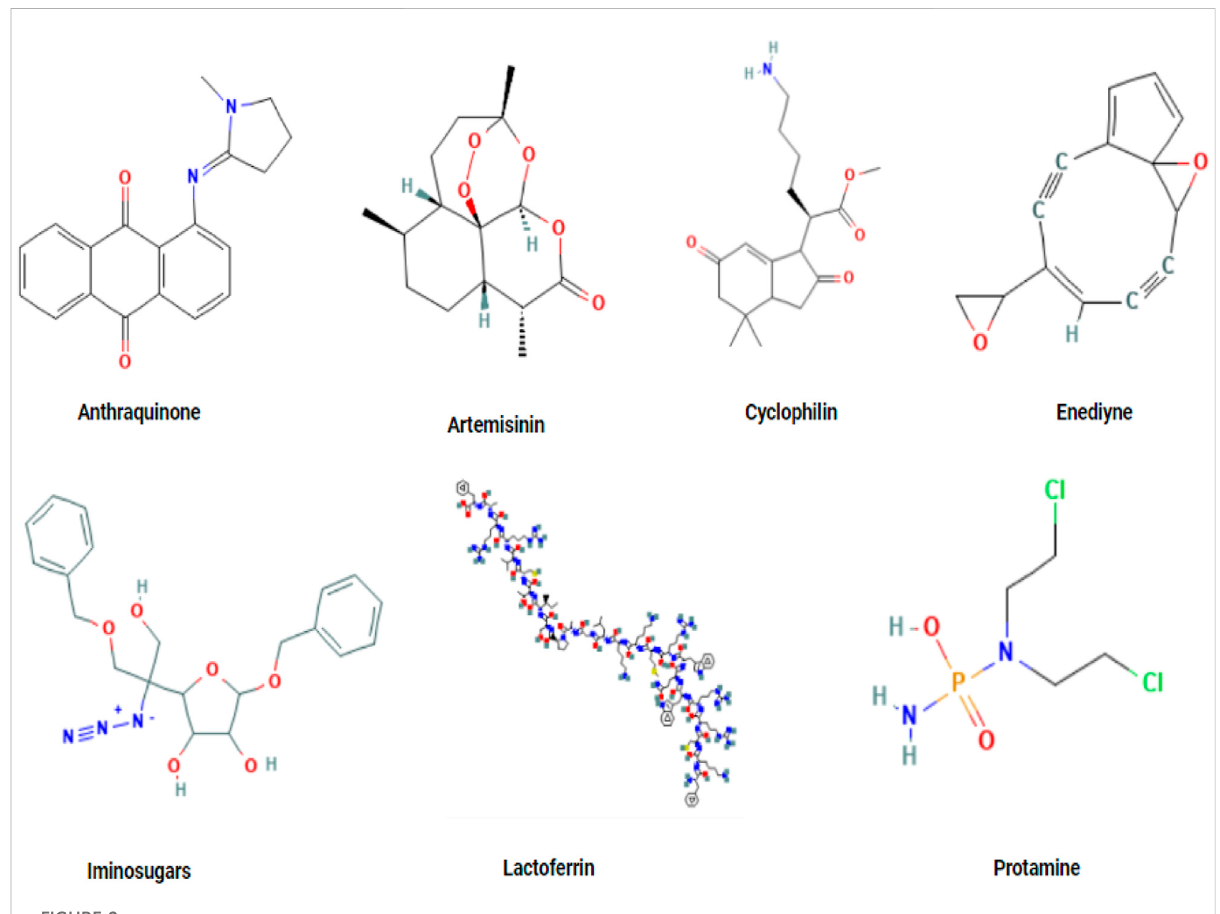
FIGURE 2 (I) HBV life cycle: (II) HCV life